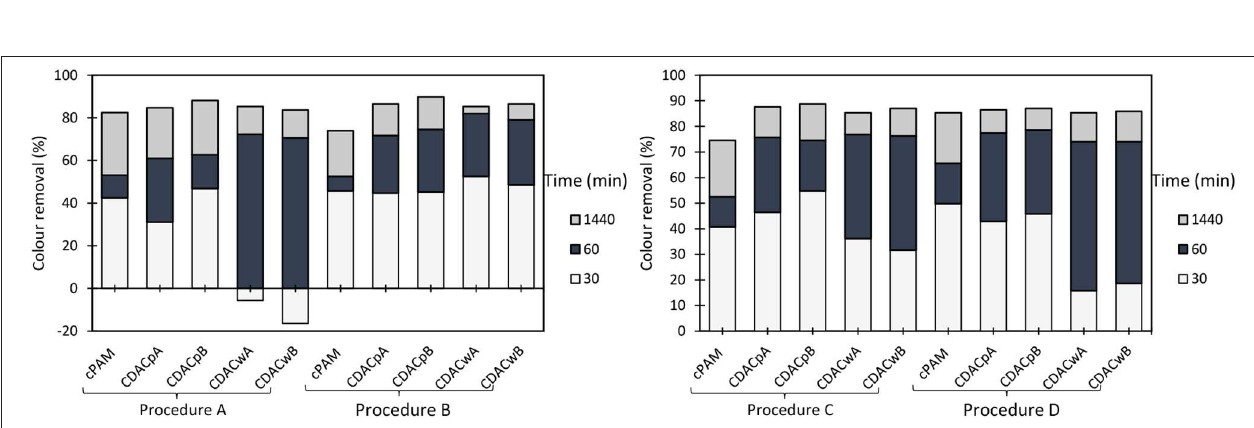
FIGURE 4 | Turbidity removal of industrial effluent as a function of time of settling, using cationic cellulose-based flocculation agents from bleached pulp (CDAC p A and B) and from wood chips (CDAC w A and B), in a dual system with bentonite, at pH 3.0. Procedure A: 0.3 wt% bentonite followed by 2.67 mg/L of flocculant. Procedure B: 0.6 wt% bentonite and 5.34 mg/L of flocculant. Procedure C: 0.3 wt% bentonite and 5.34 mg/L of flocculant. Procedure D: 0.6 wt% bentonite and 2.67 mg/L of flocculant. A cationic synthetic cPAM (in dual system with the same concentrations described in procedures A-D), was used as reference.